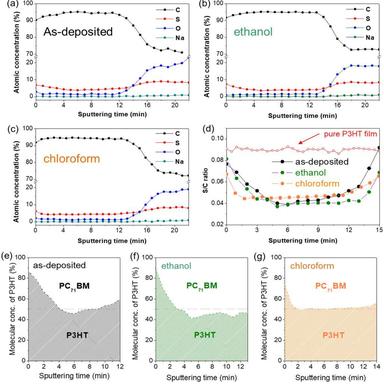
Atomic concentration depth profiles of (a) as-deposited, (b) ethanol-treated, and (c) chloroform-treated P3HT:PC71BM/PEDOT:PSS/SiO2 structures obtained from XPS analyses assisted by Ar gas cluster ion beam sputtering. (d) S/C ratio obtained from data in (a–c). (e–f) Molecular concentration profiles of the three samples.